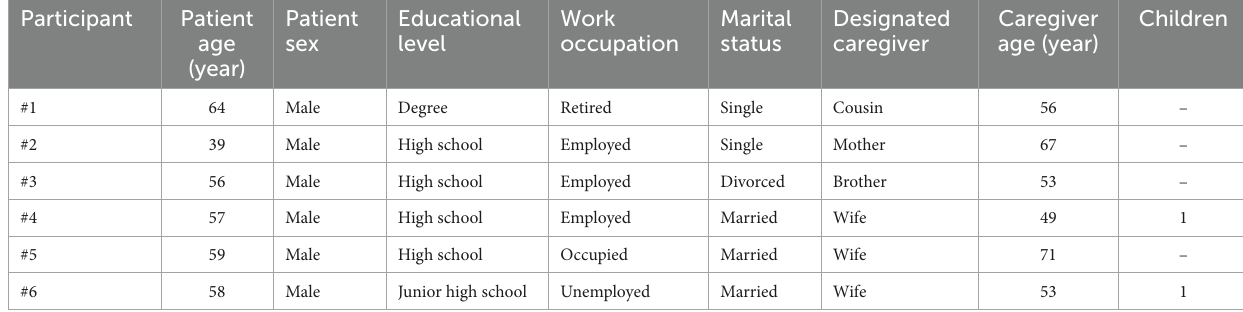
TABLE 1 Demographic characteristics of participants in the